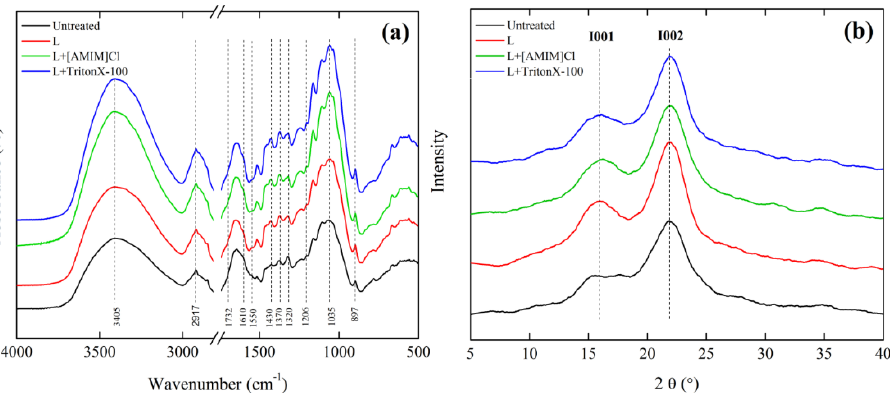
Figure 4. Spectrum analysis of rice straw under different pretreatment conditions. ( a ) FTIR spectra. ( b ) X-ray diffraction spectra.